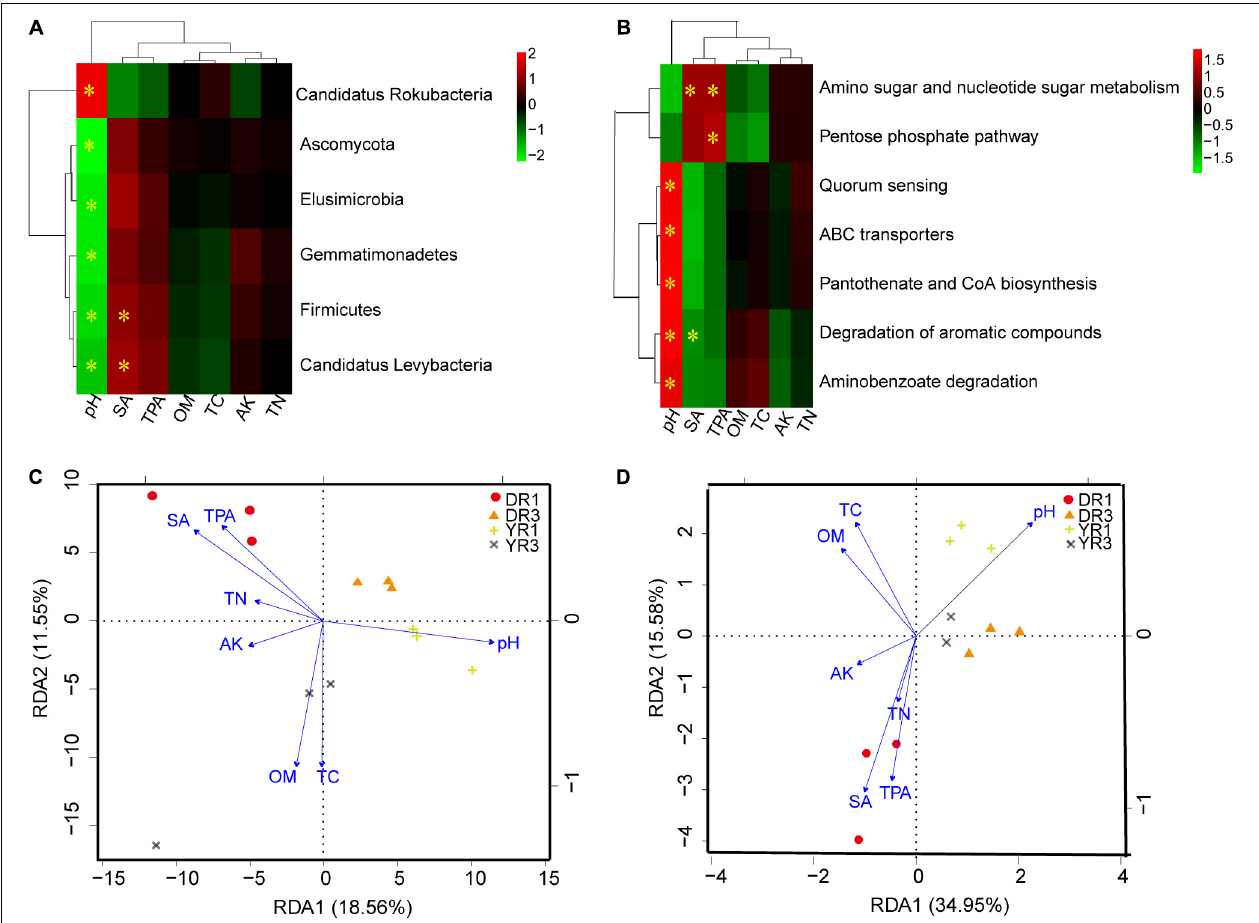
FIGURE 7 | The correlation analysis between microorganisms or KEGG pathways and soil environmental factors. (A , B) The correlation heatmap between microorganisms at the phylum level (A) or KEGG pathways (B) and soil environmental factors. The box marked with “ ∗ ” showed a significant difference ( p < 0.05). (C , D) The RDA analysis between microorganisms at the species level (C) or KEGG pathways (D) and soil environmental factors. SA, TPA, OM, TC, AK, and TN represent the contents of syringic acid, total phenolic acids, organic matter, total C, available K, and total N in rhizosphere soil. DR1 and DR3 represent the rhizosphere soil in the non- and severely diseased groups from Dali, respectively. YR1 and YR3 represent the corresponding samples from